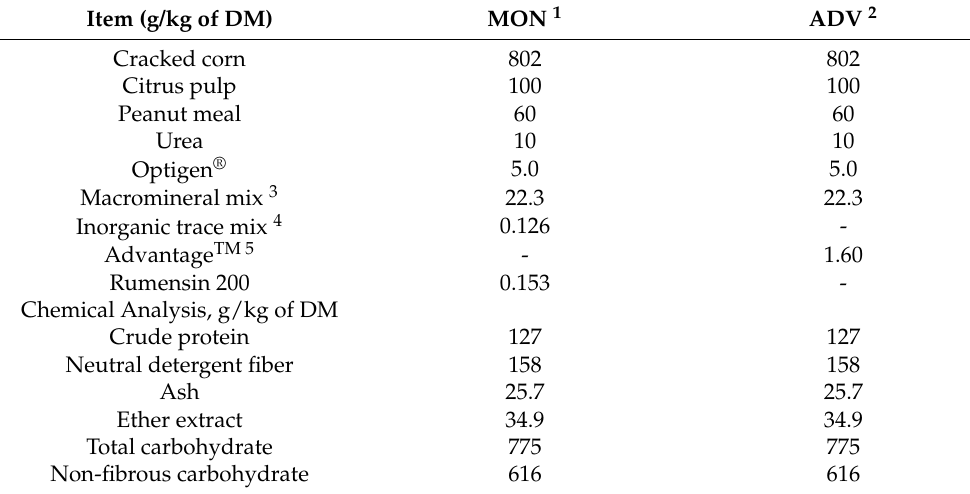
Table 1. Ingredient and nutrient composition of